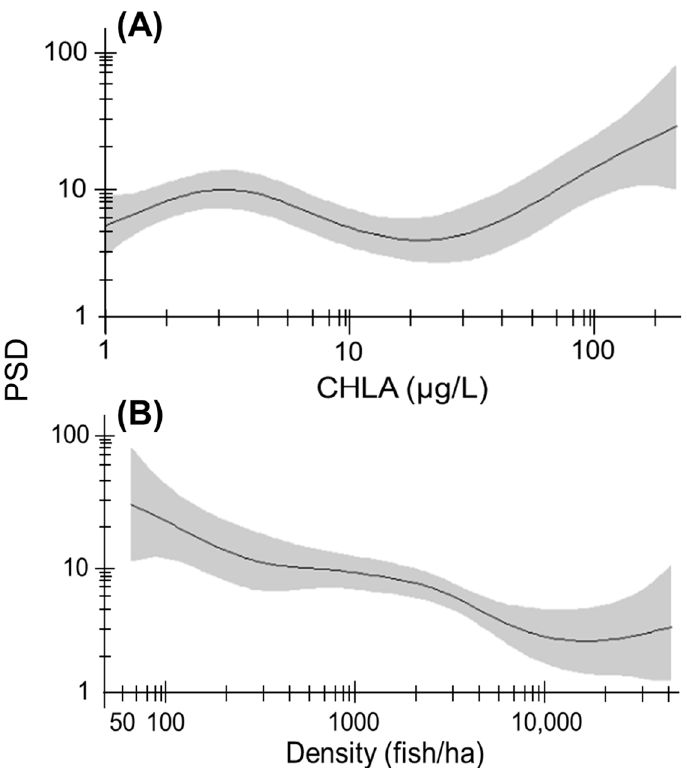
Figure 5. Generalized additive model relating Bluegill proportional size distribution (PSD) to ( A ) chlorophyll- a concentration (CHLA, μ g/L, p = 0.006) and ( B ) Bluegill density (fish/ha, p < 0.001) in Florida lakes. Shaded areas are 95% confidence intervals.